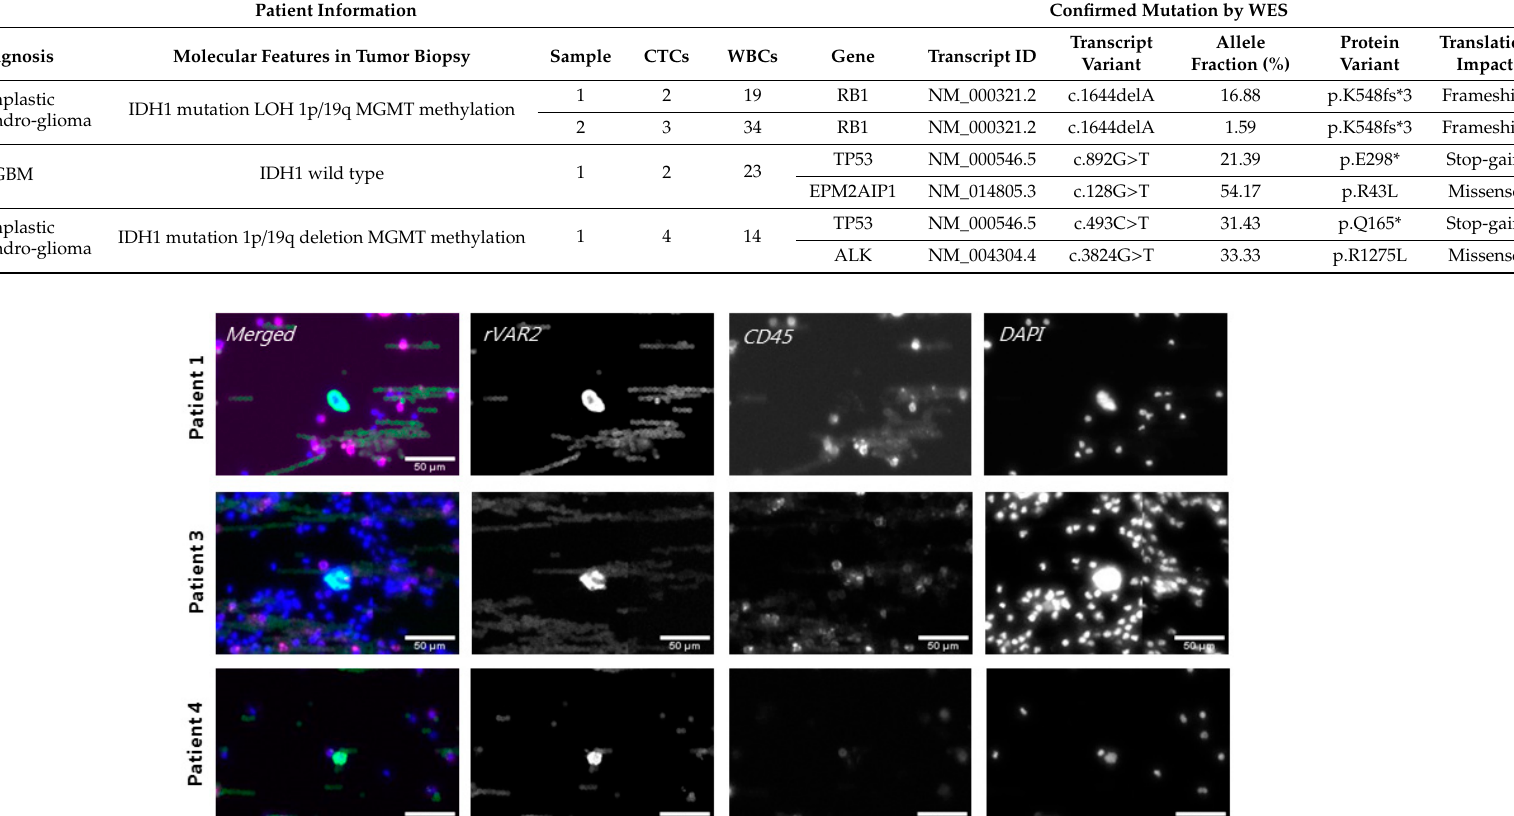
Table 2. Mutations detected in patient CTCs by whole exome sequencing (WES).